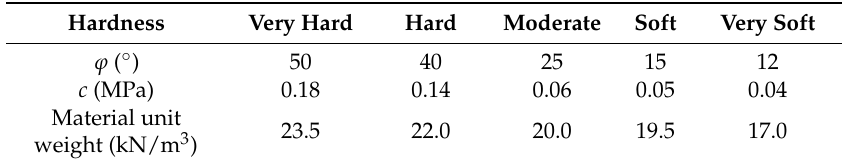
Table 1. Values of the cohesive strength ( c ) and the internal friction angle ( ϕ ) and the site categories for different lithologies classified by rock